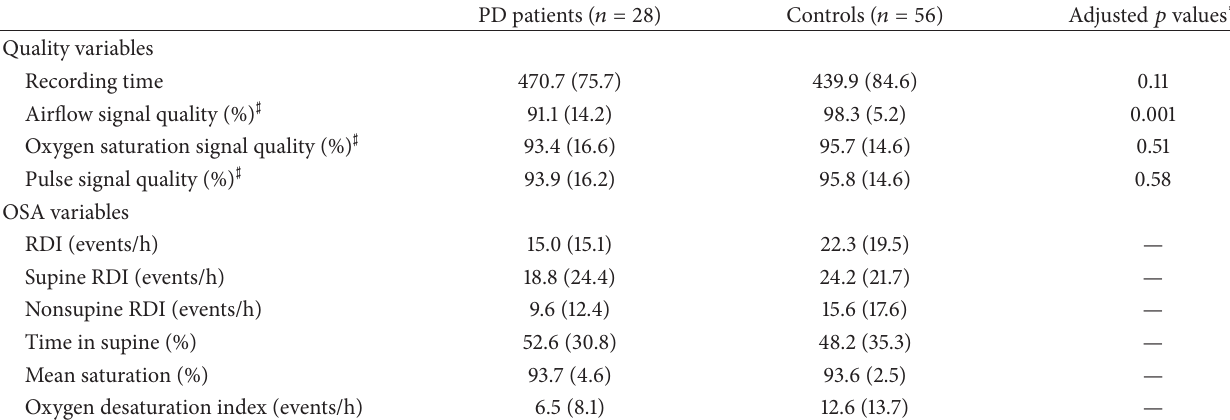
Table 3: PM data for PD patients and non-PD